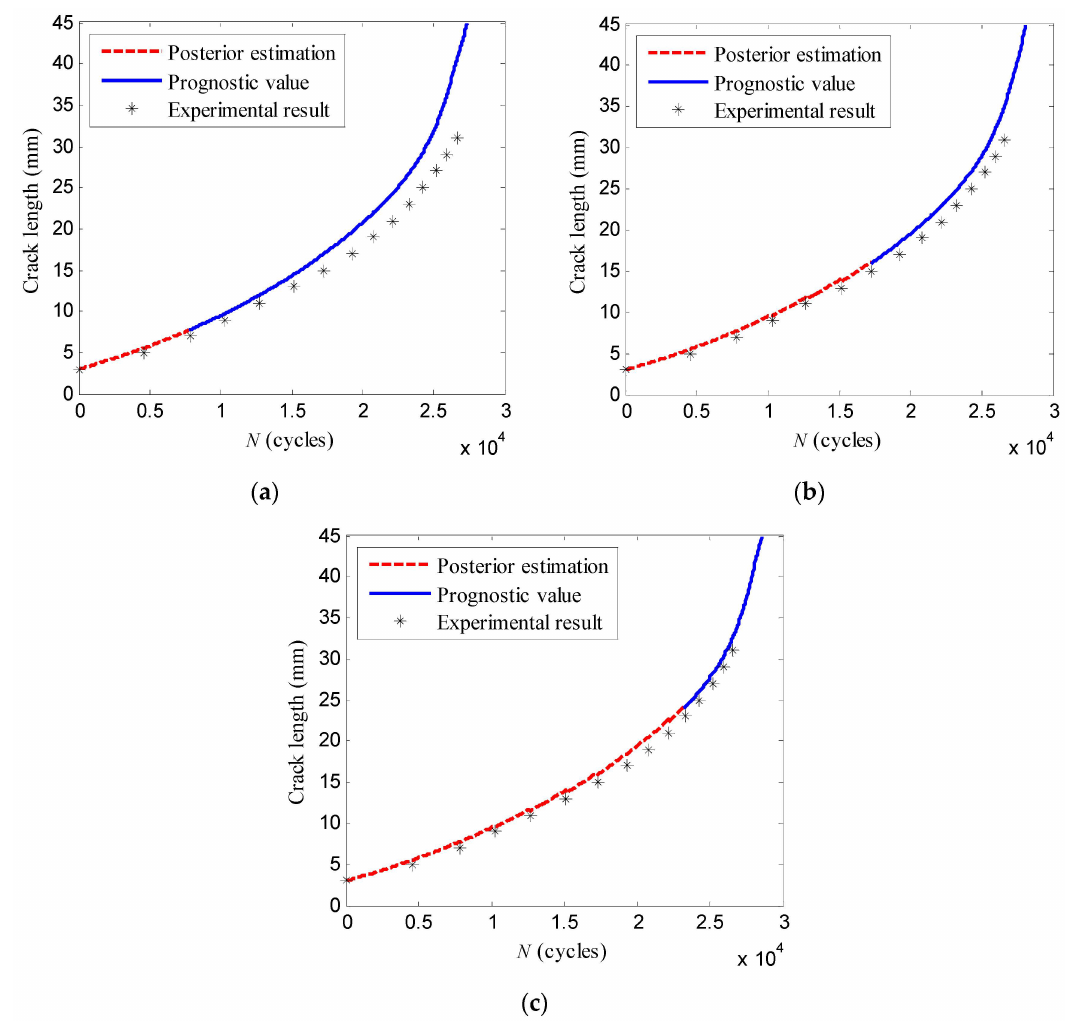
Figure 14. The crack propagation prognosis of the specimen T 5 at: ( a ) N = 7848; ( b ) N = 17,281; ( c ) N = 23,286